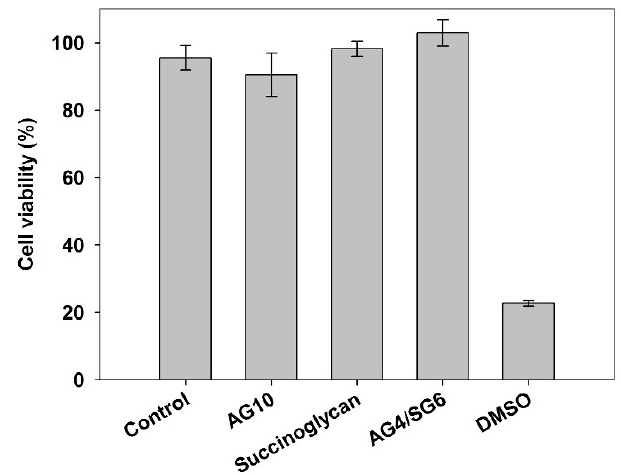
Figure 9. HEK-293 cell viability tests of control, succinoglycan, AG10, and AG4/SG6 by WST-1 assay—10% ( v / v ) DMSO was used as a positive control.